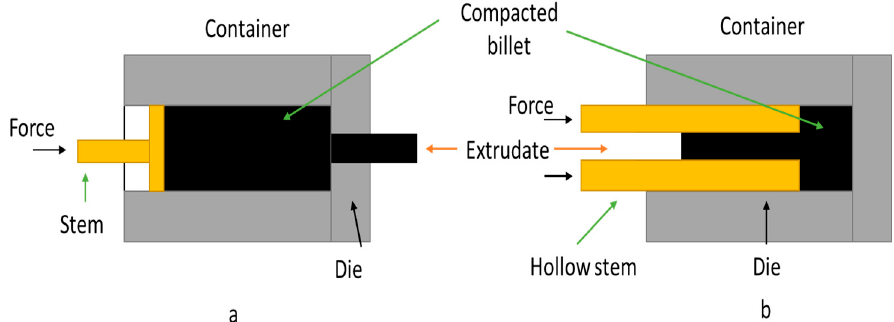
Figure 3. Difference between ( a ) direct and ( b ) indirect extrusion.